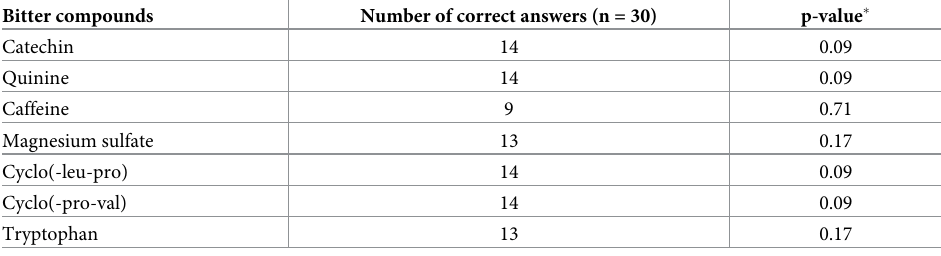
Table 4. Results of tetrad test for orthonasal evaluation of coffee aroma in seven bitter compounds and compared to